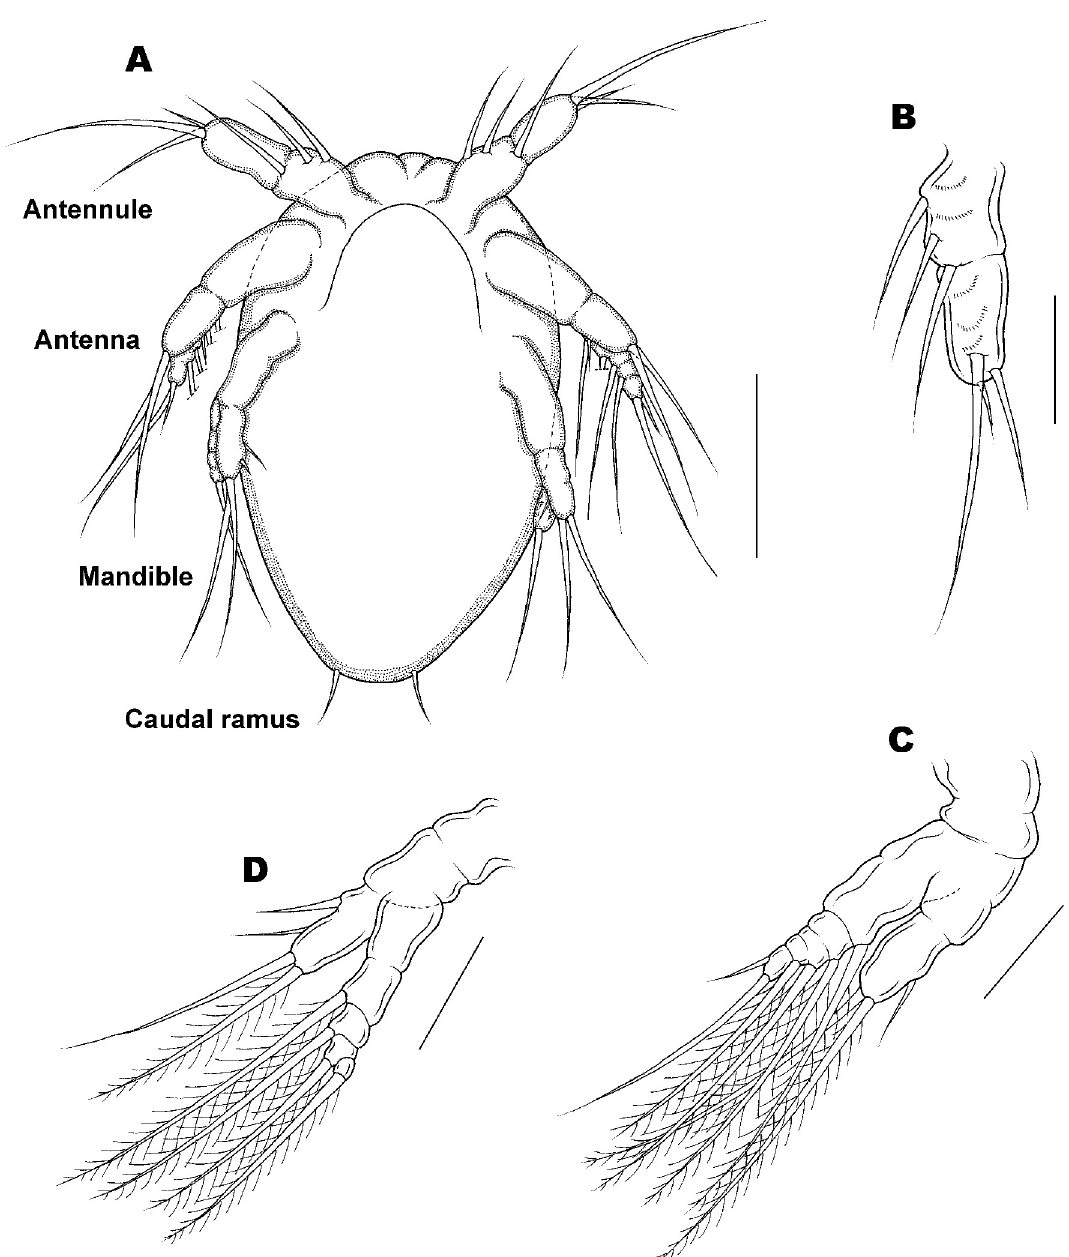
Fig 5. Nauplius stage II of Ive ptychoderae . (A) Habitus, ventral; (B) Antennule; (C) Antenna; (D) Mandible. Scale bars: A = 0.05 mm; B–D = 0.025 mm.